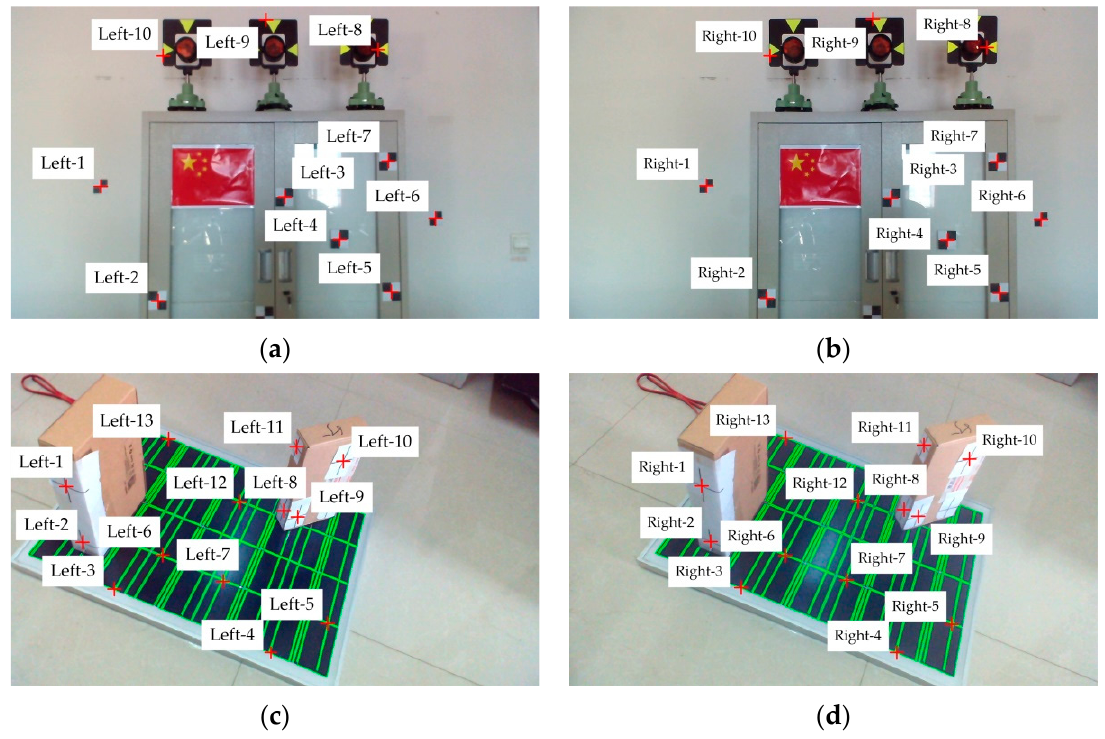
Figure 11. In the simulation experiment, ( a , b ) are the left and right images of the first photographic station and the corresponding virtual control point distribution. ( c , d ) are the left and right images, virtual control points and the extracted linear features of the second photographic station. Before adjustment, the initial value of EO must be obtained. In this study, the DLT algorithm was used to calculate the initial values of the EO elements. The error equations of the left and right images were constructed